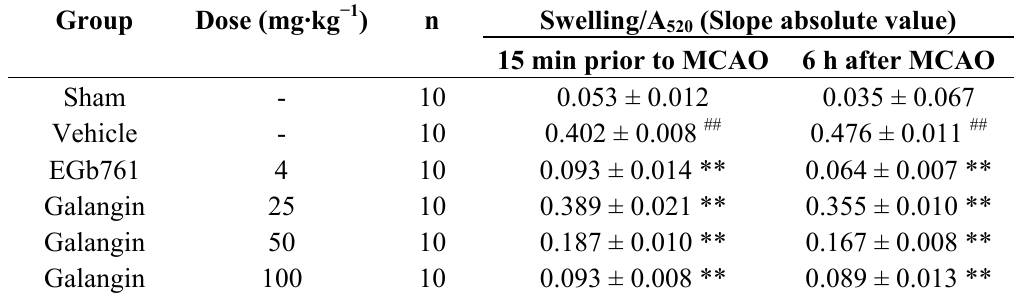
Table 1. Absorbency of slope absolute